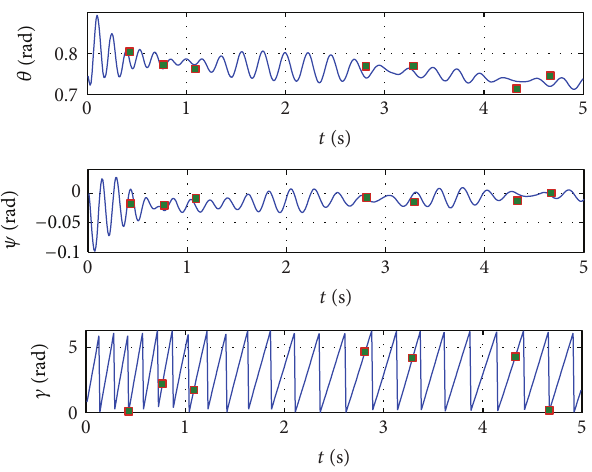
Figure 5: Attitude calculated by fast coarse alignment method.